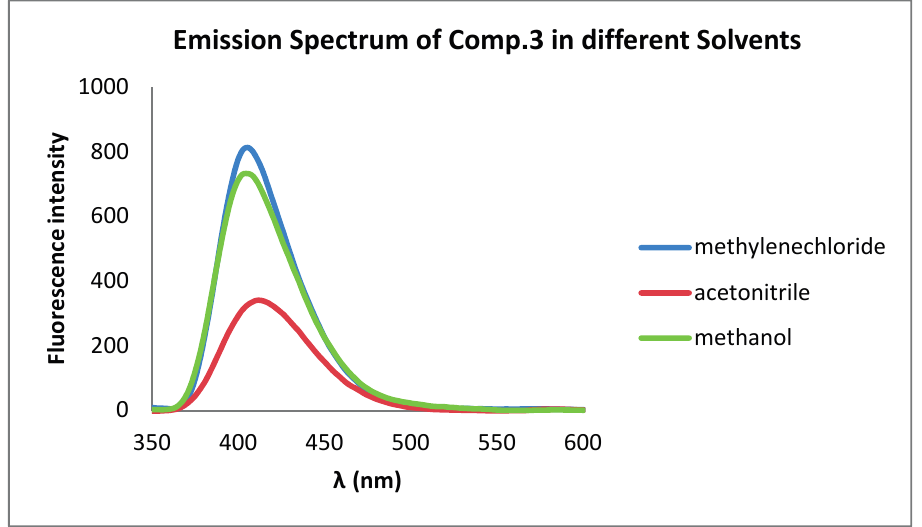
Figure 2. The fluorescence emission spectrum of compound 3 solutions in CH CH CN and CH 3